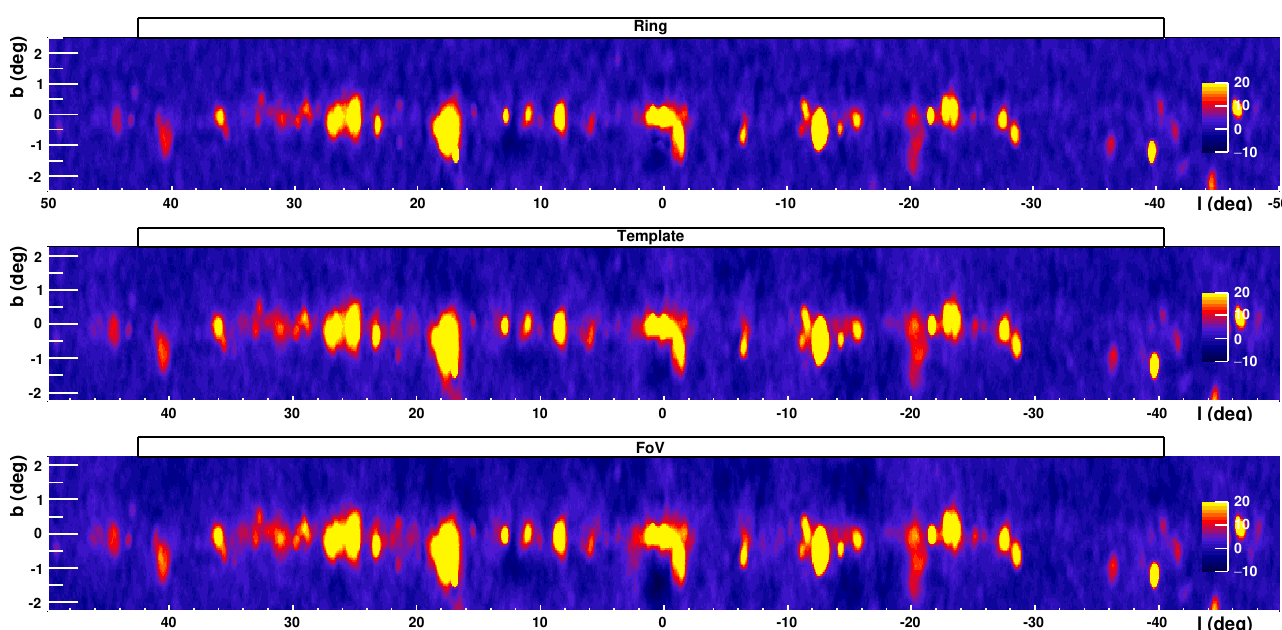
Figure 13. Comparison of three background subtraction algorithms for the inner 100 ◦ of the H.E.S.S. Galactic plane survey, with a source size of 0.25 ◦ ( Top ) ring background. ( Middle ) template background. ( Bottom ) field-of-view